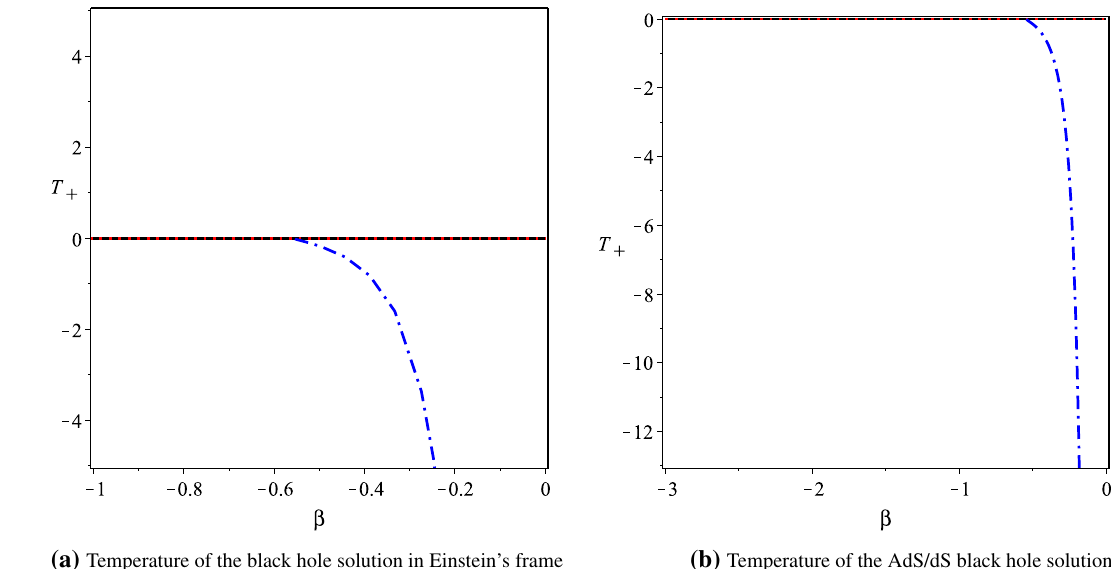
( a ) Temperature of the black hole solution in Einstein’s frame (b) Temperature of the AdS/dS black hole solution Fig. 9 Schematic plot of the black hole temperature in Einstein’s frame versus the dimensional parameter β Equation (43) are plotted in Fig. 10, showing that we have a positive entropy. We note that the entropy S is proportional to the area of the horizon, due to the fact that we are in Einstein’s